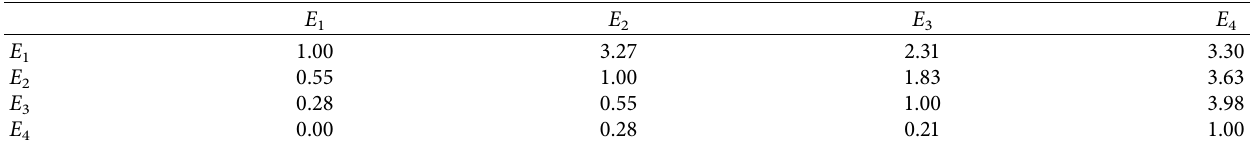
Table 5: Pairwise comparison on economic